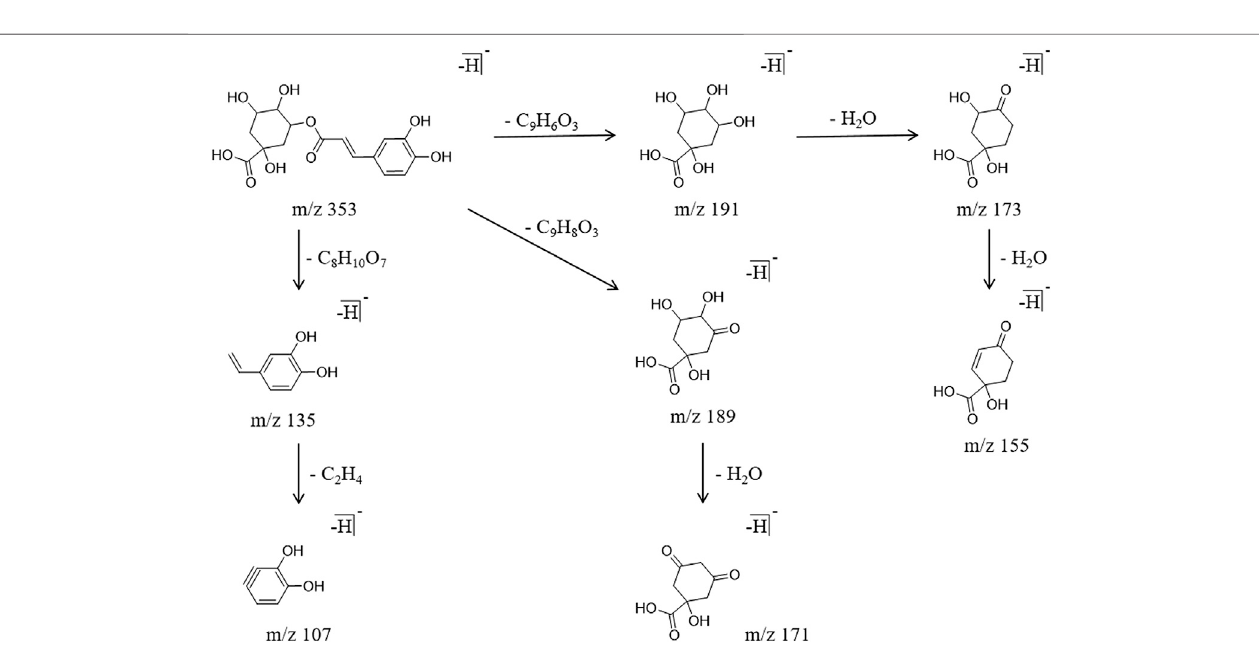
FIGURE 6 | Cracking pathway of phenolic acids.